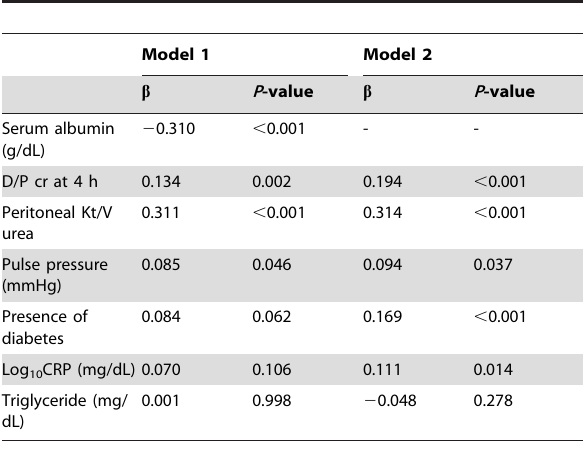
Table 2. Multivariate associations between peritoneal protein clearance and patient characteristics a